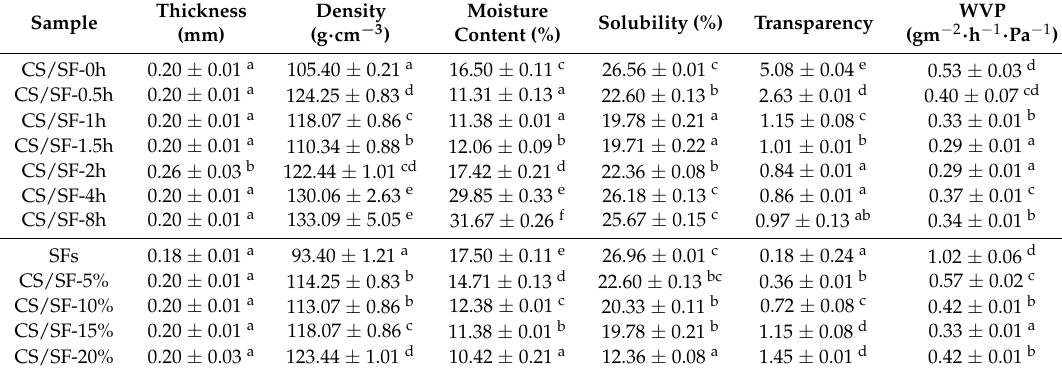
Table 3. Physical properties of starch-based films blended with corn straw of different ball grinding times and addition amounts. SF—starch-based